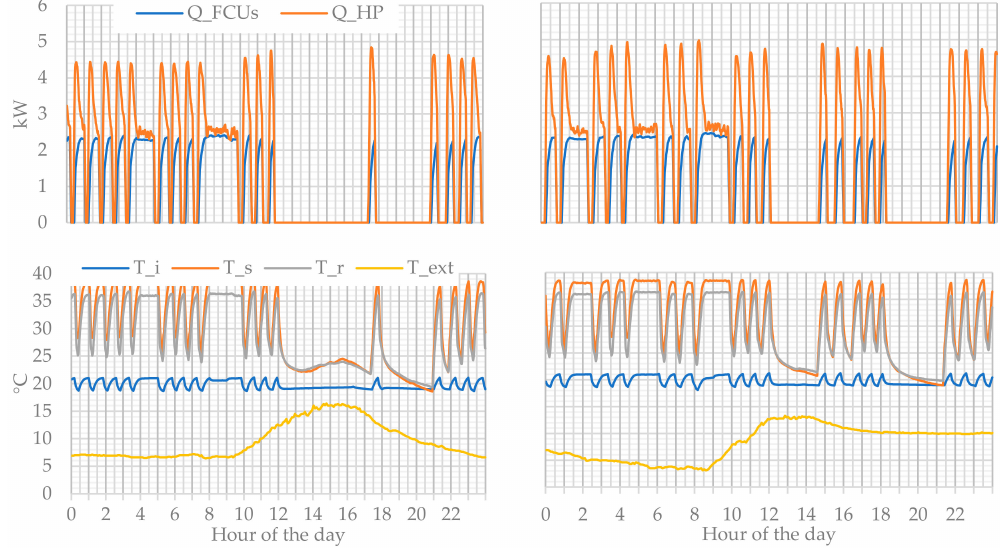
Figure 7. Typical mild ( left ) and cold ( right ) days under MOD#2 (22-Jan.,